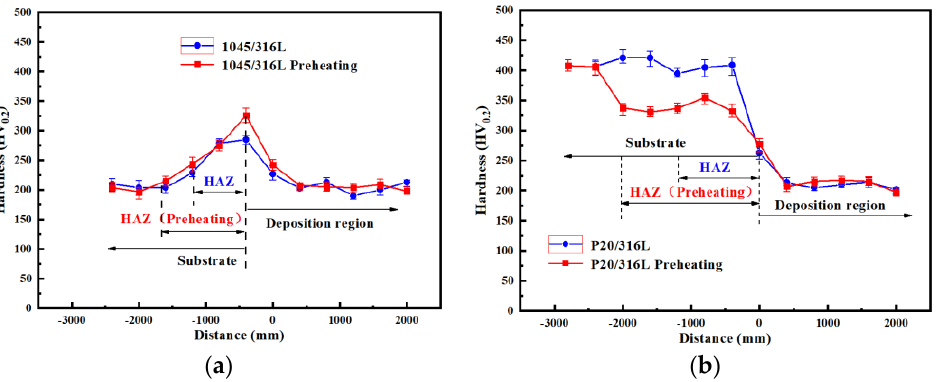
Figure 14. Microhardness profiles along depth direction on the transverse cross section: ( a ) from 1045 substrate to 316 L steel; ( b ) from P20 substrate to 316 L steel.